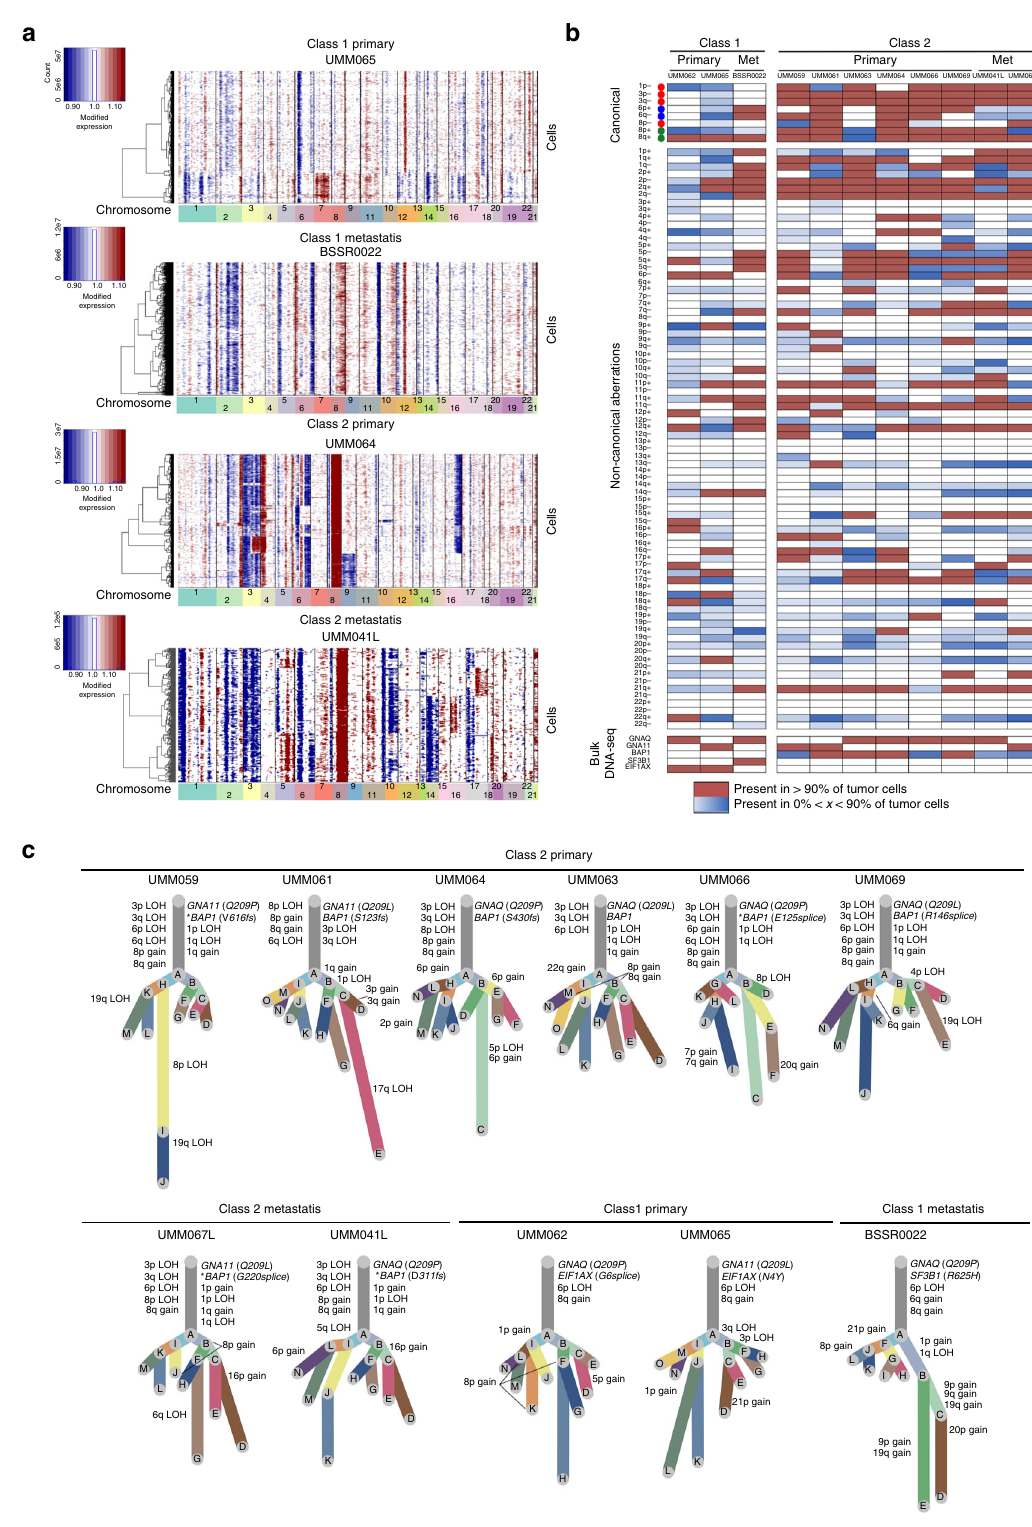
Fig. 2 Single cell copy-number variation analysis of primary and metastatic uveal melanomas. a Representative CNV heatmaps with hierarchical clustering from inferCNV analysis from each GEP class. b Summary plot of the CNV pro fi les from each of the 11 patients inferred from their scRNA-seq data. CNVs were annotated by the chromosome arm in which the CNV event calculated by inferCNV occurred. Canonical CNV events in UM are shown at the top as annotated (red, class 2; blue, class 1; green, class 1 and 2). Source data are provided as a Source Data fi le. c Clonality trees of each of the 11 patients separated by GEP class. The branches are scaled according to percentage of cells in the calculated subclone containing the corresponding CNVs. *indicates mutations that were found to occur in a subclone by bulk DNA sequencing and thus could not be assigned to a speci fi c branch of the